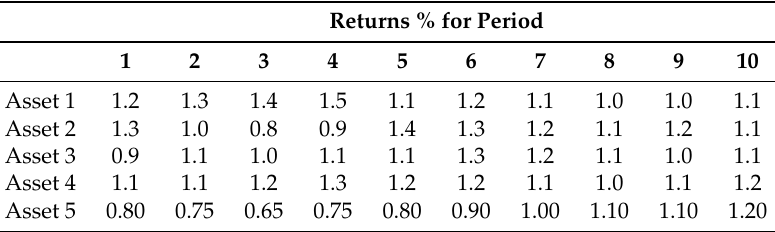
Table 1. Rates of return on five assets over ten period.